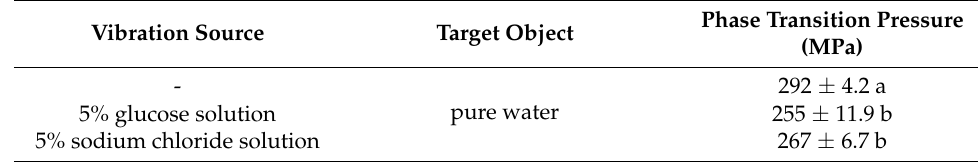
Table 4. The phase transition pressure of pure water in internal vibration